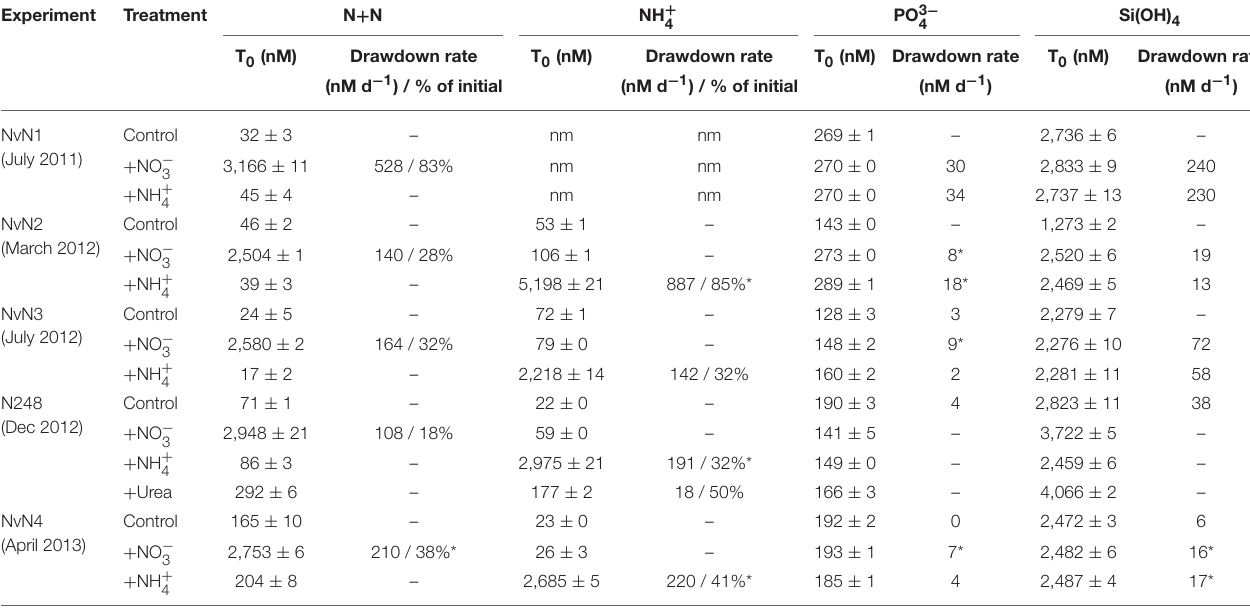
TABLE 2 | Concentrations and rates of consumption of N + N, NH + 4 , PO 3 − 4 , and Si(OH) 4 at initial time point (T 0 ) of experiments.